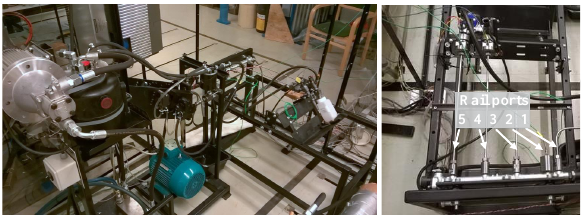
Figure 1: CR test system at Tampere University of Technology (TUT). Port 1 (from the right): supply line, Port 2: rail pressure (Kistler), Port 3: temperature (K Type thermocouple), Port 4: injector (not studied) and Port 5: studied